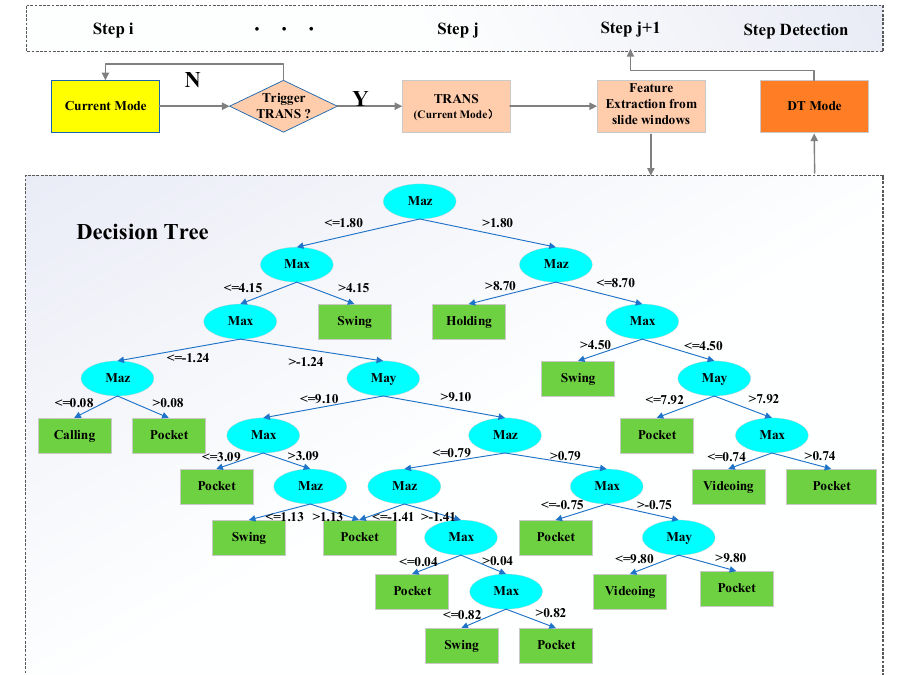
Figure 6. Smartphone mode monitoring and recognition.